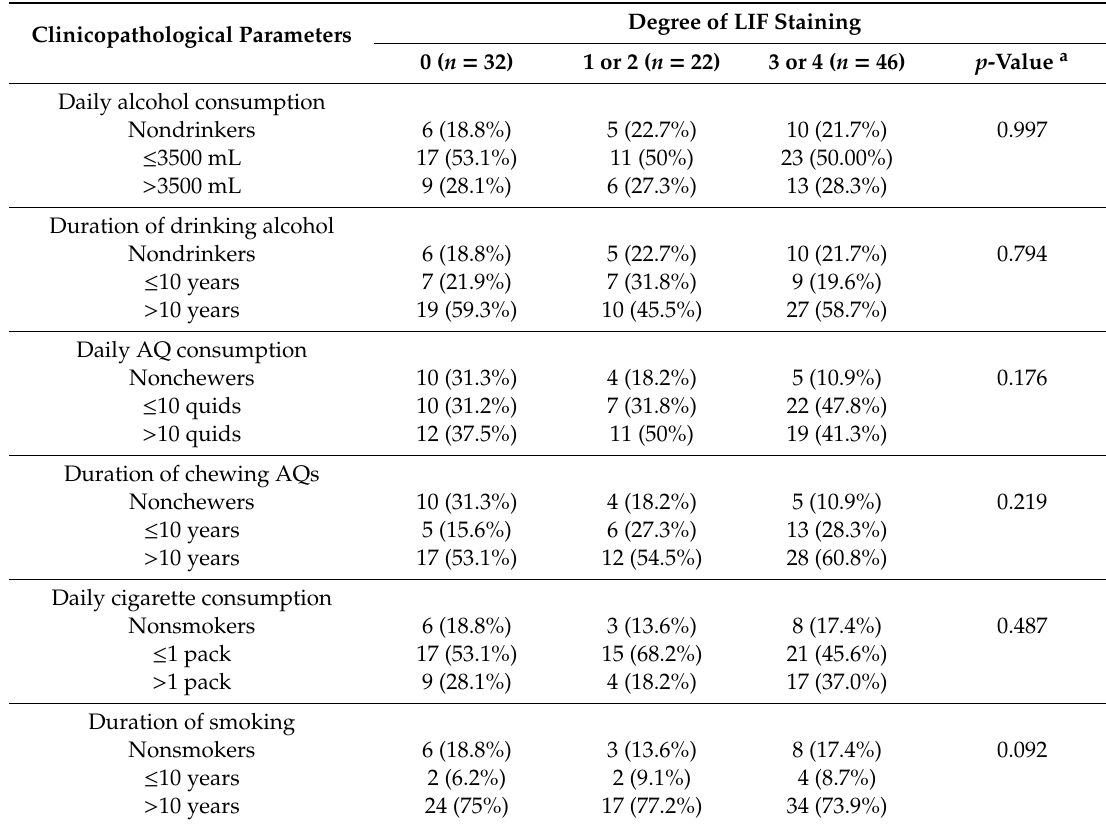
Table 3. Correlation between LIF expression and habits of betel nut chewing and tobacco smoking. Clinicopathological